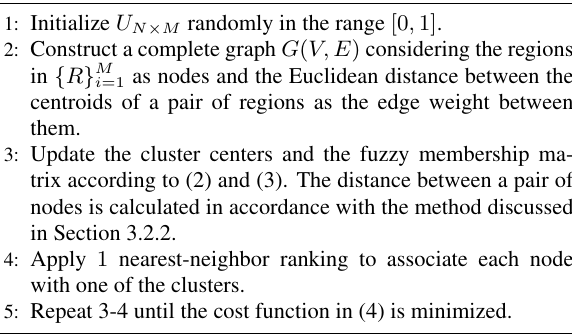
Algorithm 1 describes the proposed graph based fuzzy clustering